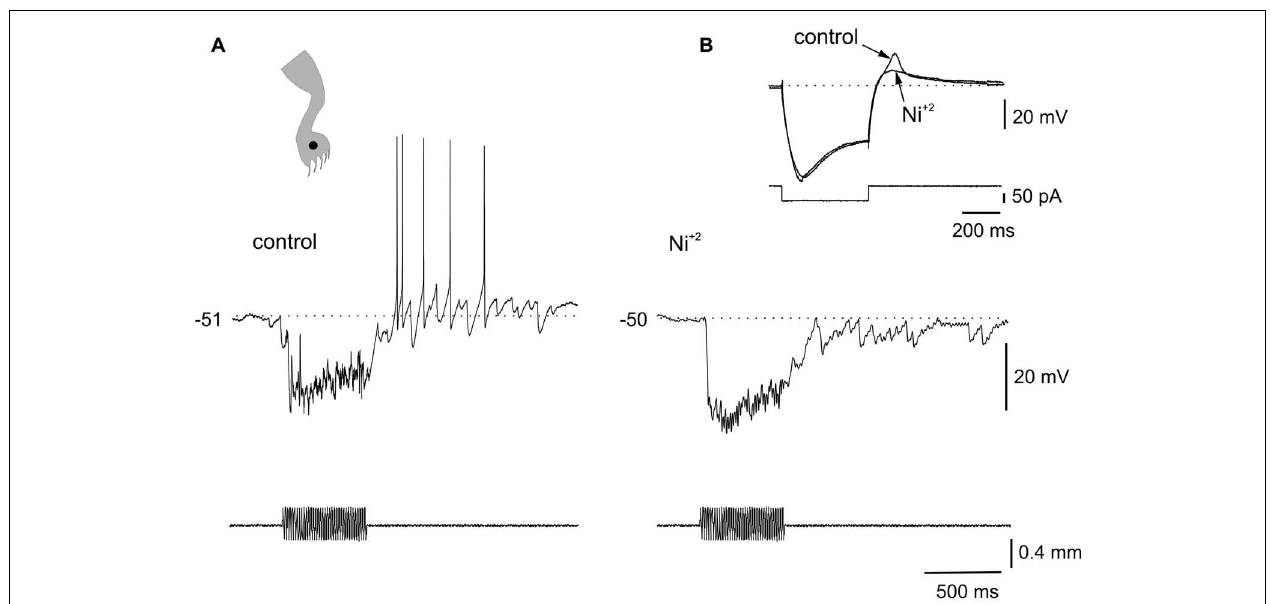
FIGURE 3 | Ionic mechanisms of the interaction between LTS and sensory inputs. (A) Sinusoidal (70 Hz) mechanical stimulation applied on the ipsilateral leg (dot in cartoon) produced a strong hyperpolarization followed by spiking generated by post-inhibitory rebounds. (B) In the presence of Ni 2 +